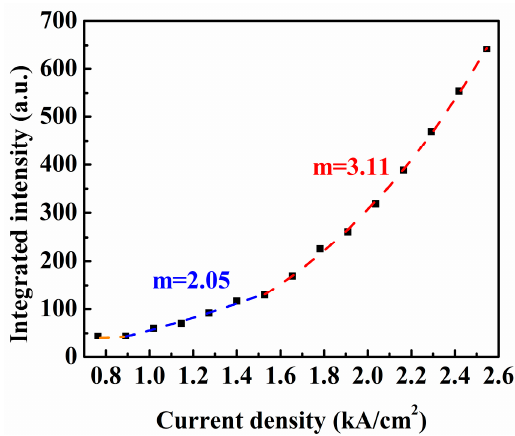
Figure 8. The relationship between the integrated intensity ( L ) from diode and injection current density ( J ) characterized empirically by L ~ J m .